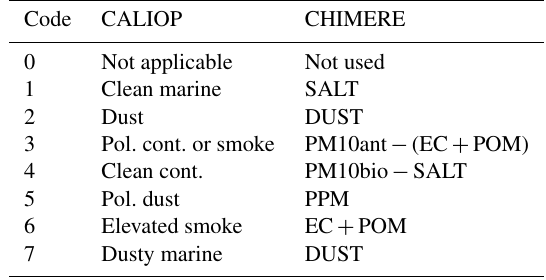
Table B1. Correspondence between CALIOP “optical indexes” and CHIMERE “aerosol concentrations”.